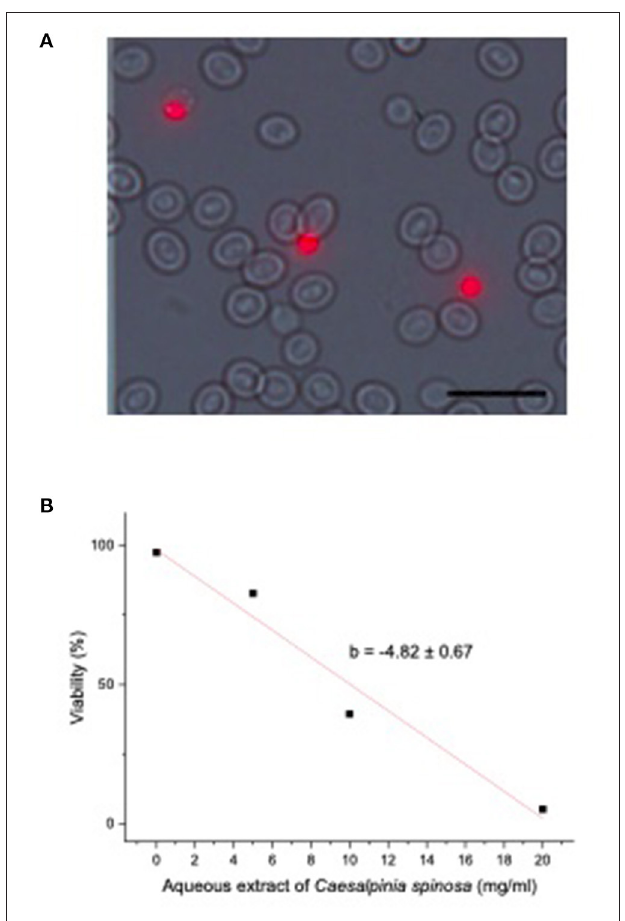
FIGURE 2 | (A) Peripheral blood erythrocytes from Oreochromis niloticus stained with propidium iodide. Dead cells can be recognized as red nuclei observed through fluorescence microscope (Olympus B51), 40 × . Bar: 25 µ m. (B) Viability ex vivo of erythrocytes from O. niloticus exposed to Caesalpinia spinosa aqueous extract, DL 50 = 10.50